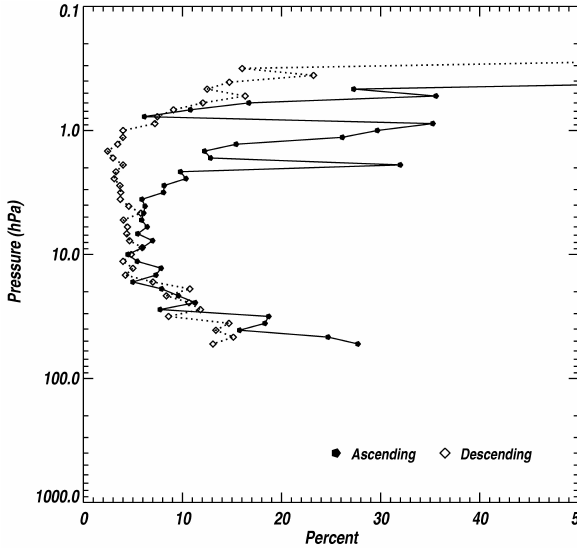
Fig. 5. As in Fig. 4, but for estimates of precision (SD) for LIMS V6 NO 2 profiles.